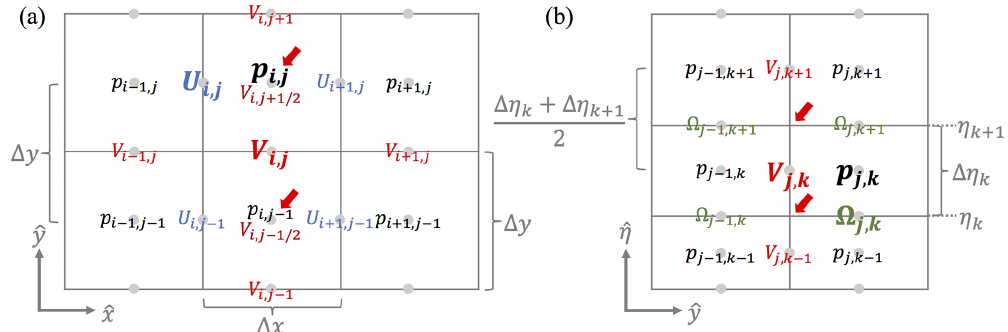
Figure 6. (a) Horizontal and (b) vertical C staggering grids for different variables in the WRF model. Note that variables φ and W are allocated on the same grid as (cid:127) ; µ , α , and q ∗ are on grid same as p . The red arrows indicate the grids that would be used to calculate the second-order spatial derivative term for the V momentum at the V grid ( i , j , k